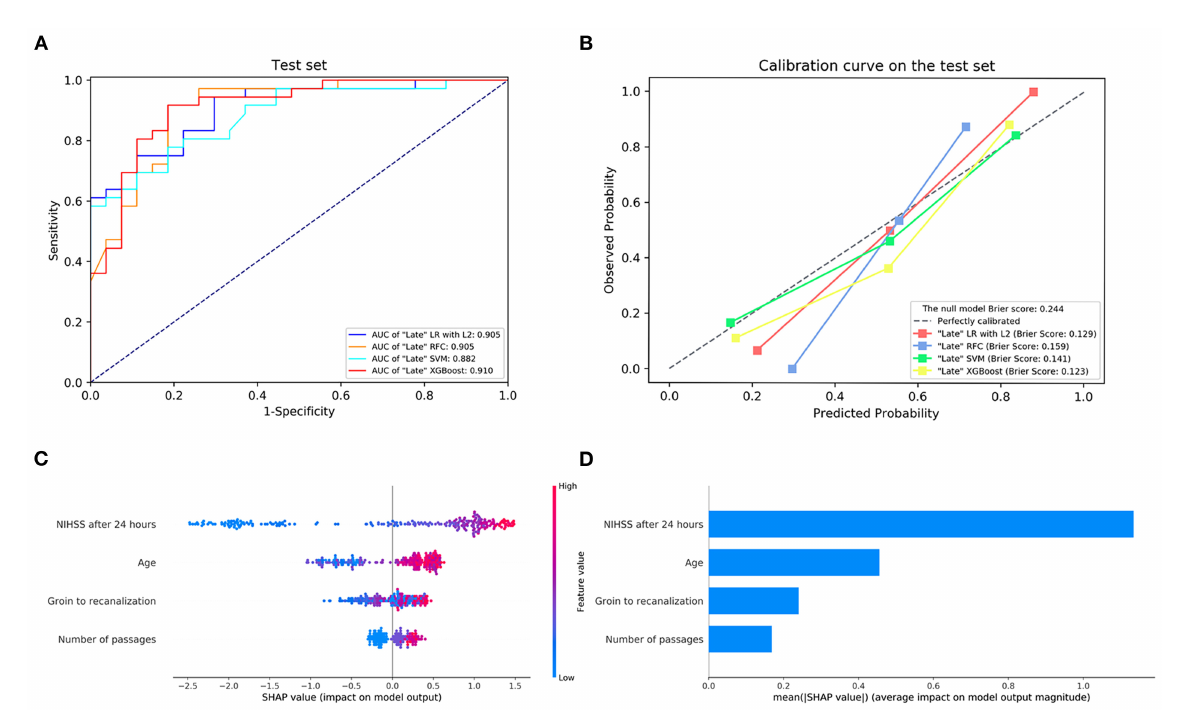
FIGURE2 (A) The receiver operating characteristic curve and (B) the calibration curve of the “Late” machine learning models on the testing set. (C,D) Feature importance ranking based on Shapley Additive exPlanations (SHAP) values in “Late” XGBoost. AUC, area under the curve; LR with